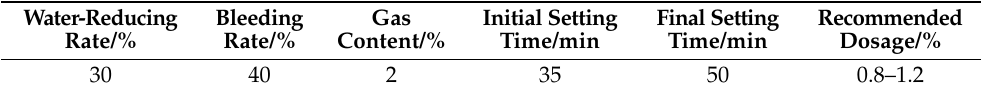
Table 1. Chemical composition of the cement. Table 2. Performance indexes of high-performance water reducer.